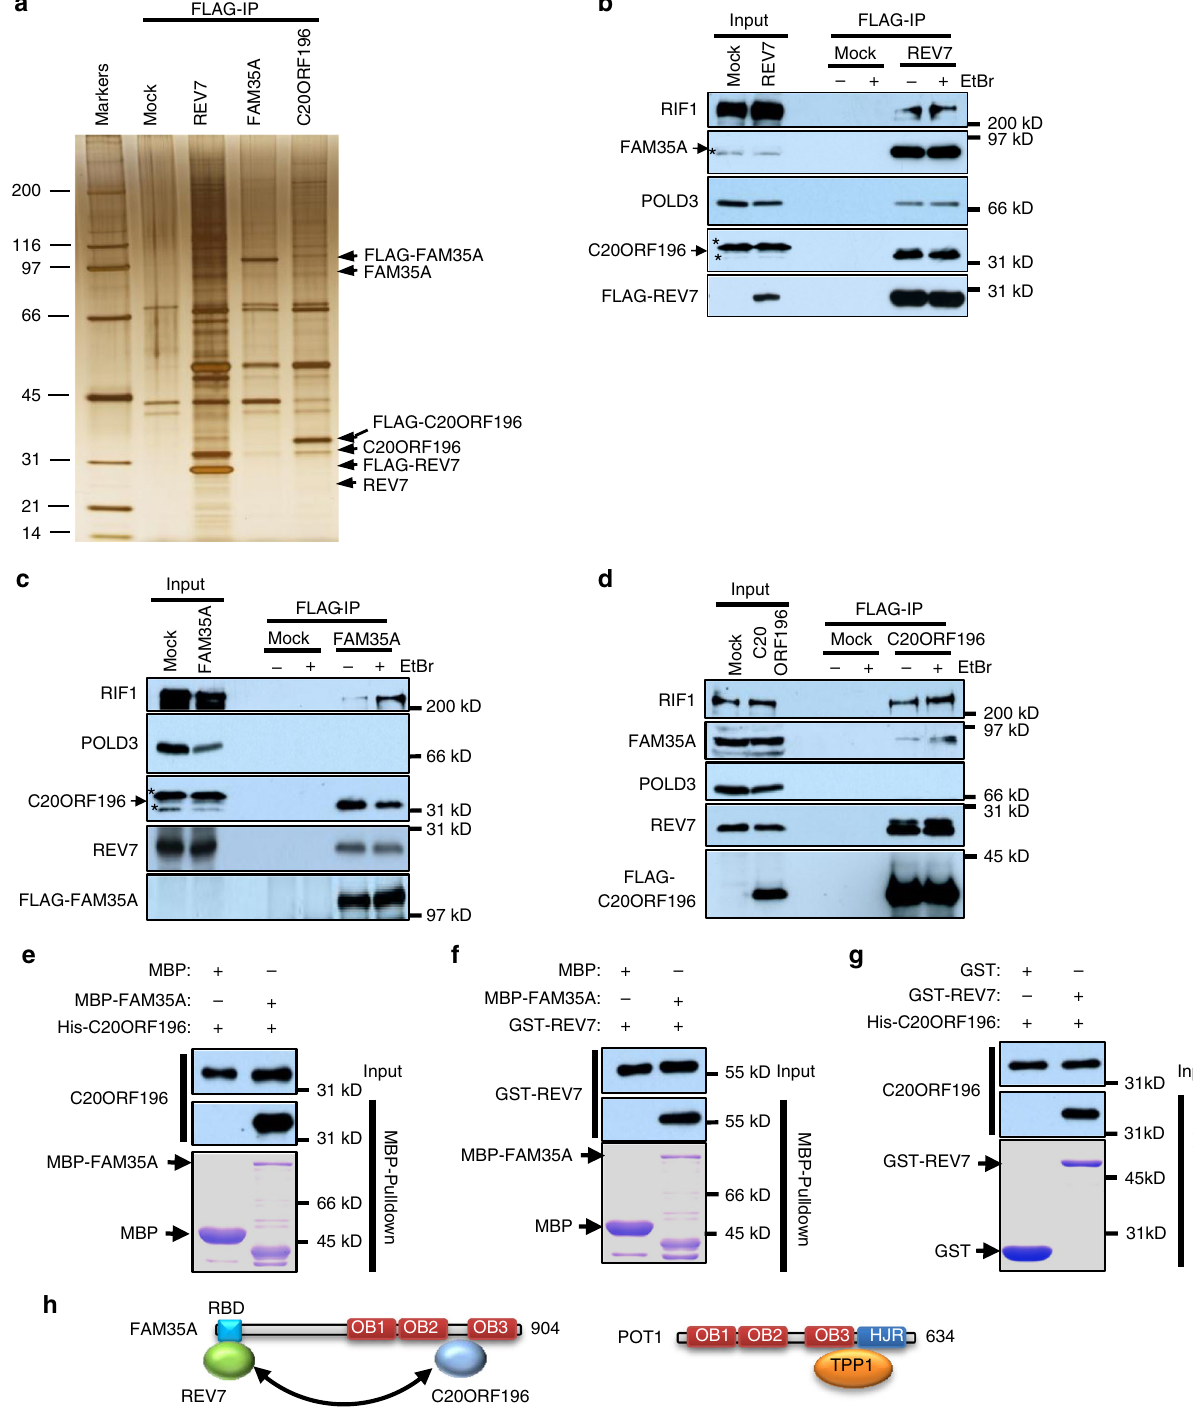
Fig. 1 FAM35A and C20ORF196 form a complex with REV7. a Silver-stained SDS-PAGE gel showing the polypeptides that were immunopuri fi ed from extracts of HEK293 cells expressing FLAG-tagged REV7, FAM35A and C20ORF196 using the anti-FLAG antibody. The major polypeptides on the gel (arrows) were identi fi ed by mass spectrometry. b – d Immunoblot showing the IP of FLAG-tagged REV7 ( b ), FAM35A ( c ) and C20ORF196 ( d ). IPs were performed with or without 100 μ g ml – 1 EtBr. The cross-reactive bands were indicated as asterisks. e – g MBP-pulldown ( e , f ) and GST-pulldown ( g ) examined the direct interactions among REV7, FAM35A and C20ORF196. The bait and prey proteins were detected with Coomassie blue staining and immunoblotting, respectively. h Schematic representation of FAM35A and